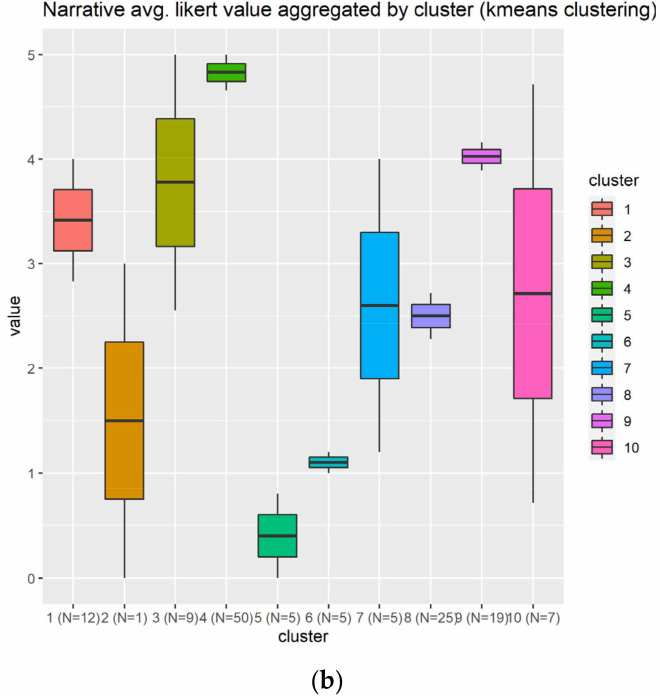
Figure 12. The answer for the narrative element has many clusters (10) indicating a heterogeneity of opinions, as can be seen in subplot ( a ). Boxplots in subfigure ( b ) show 4 of the 10 with a large IQR and 4 of 10 with small IQR, which are the interesting